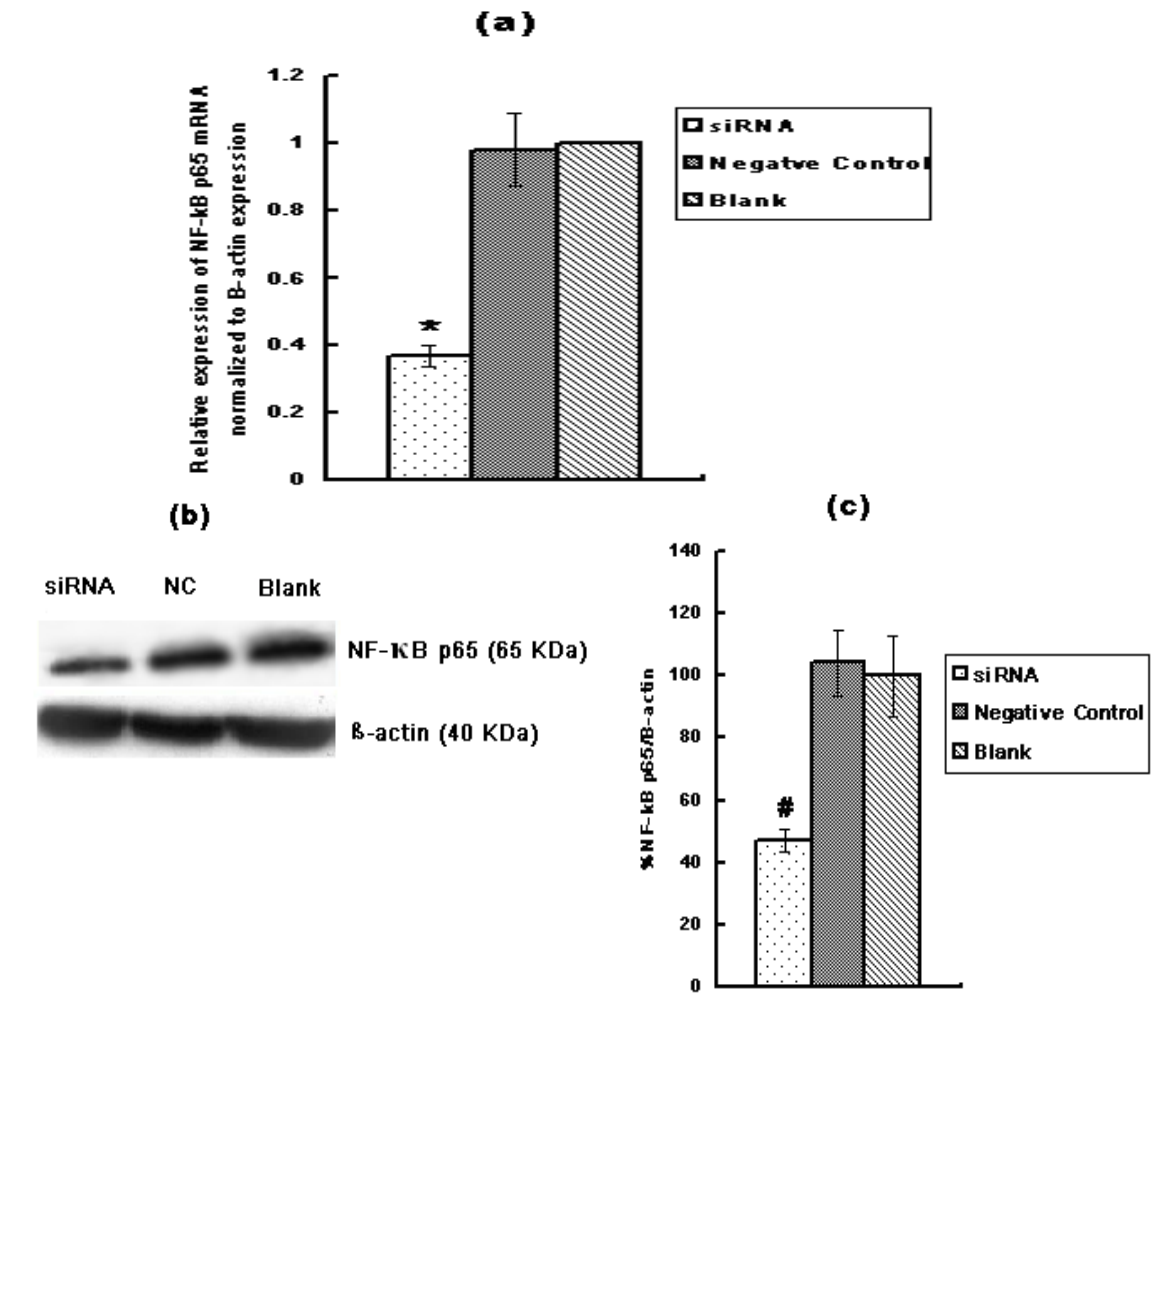
Figure 6. The effect of RAGE siRNA on the expression of NF-κB p65 in Huh7 cells by qRT-PCR and Western Blot. ( a ) Relative expression of NF-κB p65 mRNA normalized to β-actin expression ( vs. blank control) analyzed by qRT-PCR; ( b ) Western Blot protein bands film results; ( c ) Expression of NF-κB p65 protein as a ratio to β-actin; ( * p < 0.01, # p < 0.05). Three independent measurements were made and averaged. NC: Negative Control